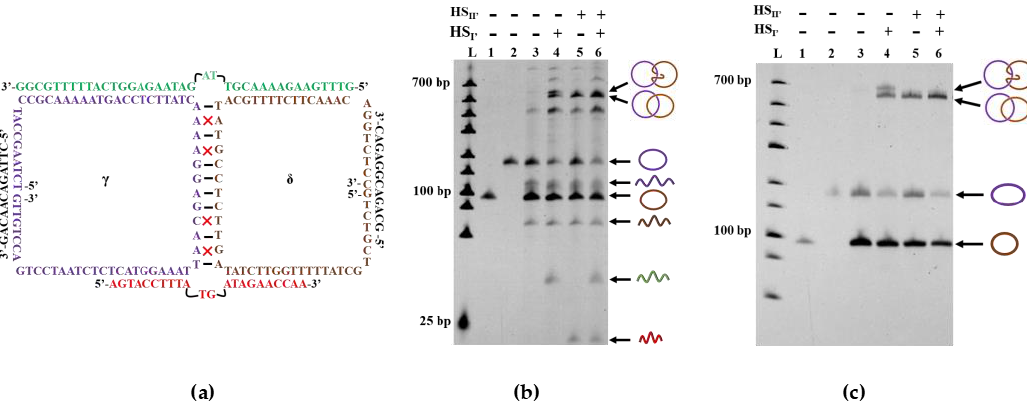
Figure 4. Successful preparation of Lk 1 catenane in the presence of only four consecutive complementary base pairings between two quasi-rings γ and δ . ( a ) Sequences of two quasi-rings γ (72 nt) and δ (59 nt) as well as of two holder strands of HS I’ (38 nt) and HS II’ (22 nt). There are four mismatches (marked as red crosses) in the 12-bp complementary part between two rings. Two base pairings, in the middle of HS I’ and HS II’ , are kept out of the hybridization region between the holder strand and two rings to minimize the spatial hinderance and make the two rings intertwine more easily; ( b ) dPAGE analysis (14%) of the catenation products. Lane 1, the γ ring; lane 2, the δ ring; lane 3, catenation in the absence of HS I’ and HS II’ ; lane 4, catenation in the presence of only HS I’ ; lane 5, catenation in the presence of only HS II’ ; lane 6, catenation in the presence of both HS I’ and HS II’ . ( c ) Treatment of the ligation products in ( b ) with Exonuclease I to remove the linear ssDNA byproducts.